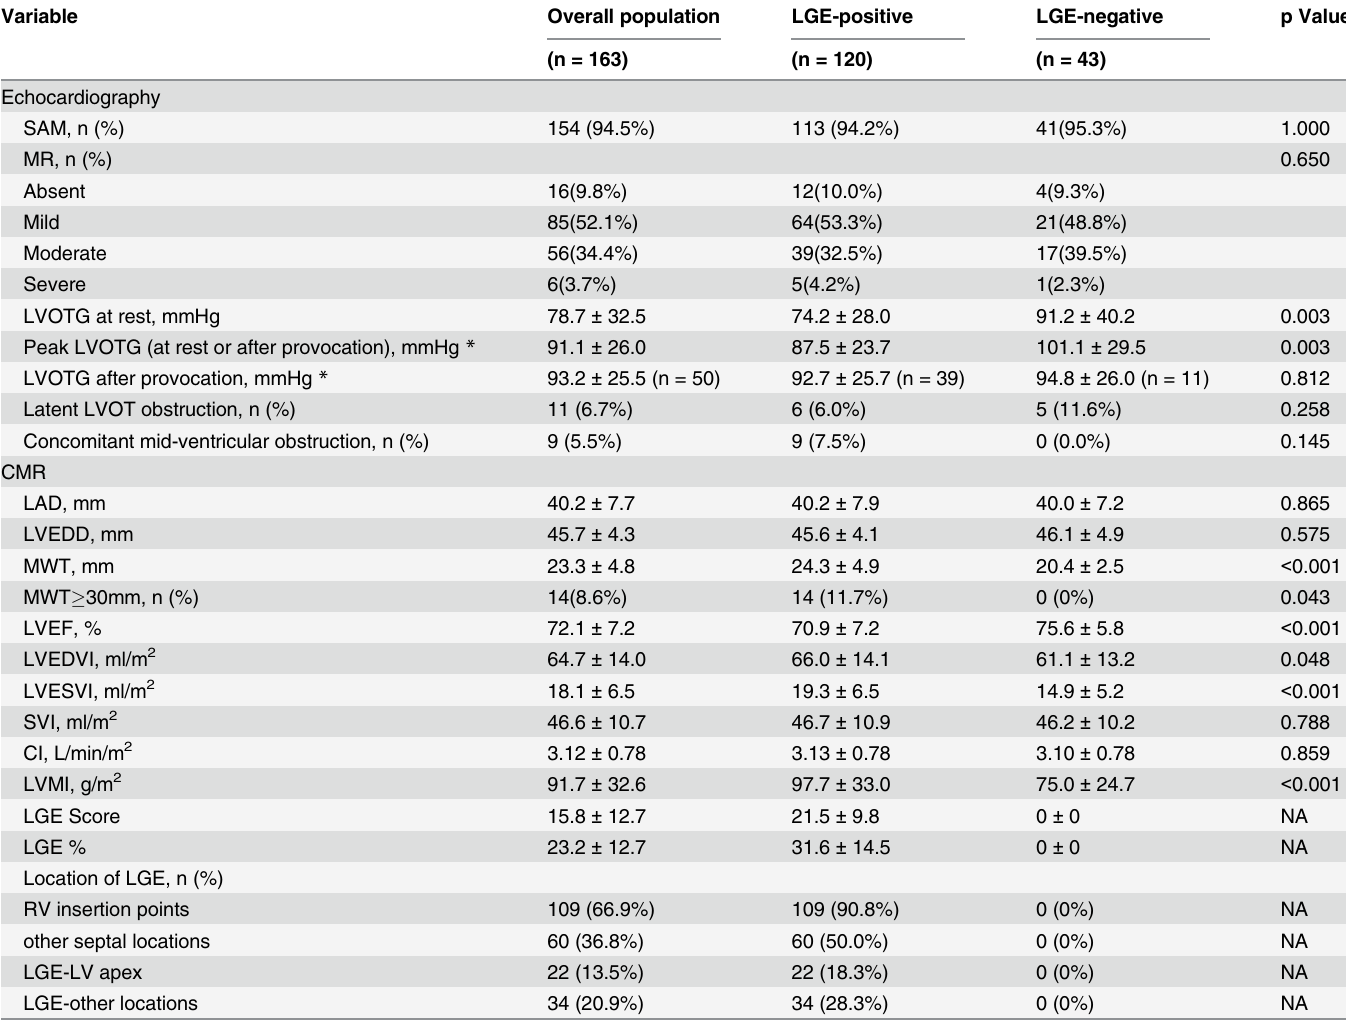
Table 2. Echocardiography and CMR data of patients with and without